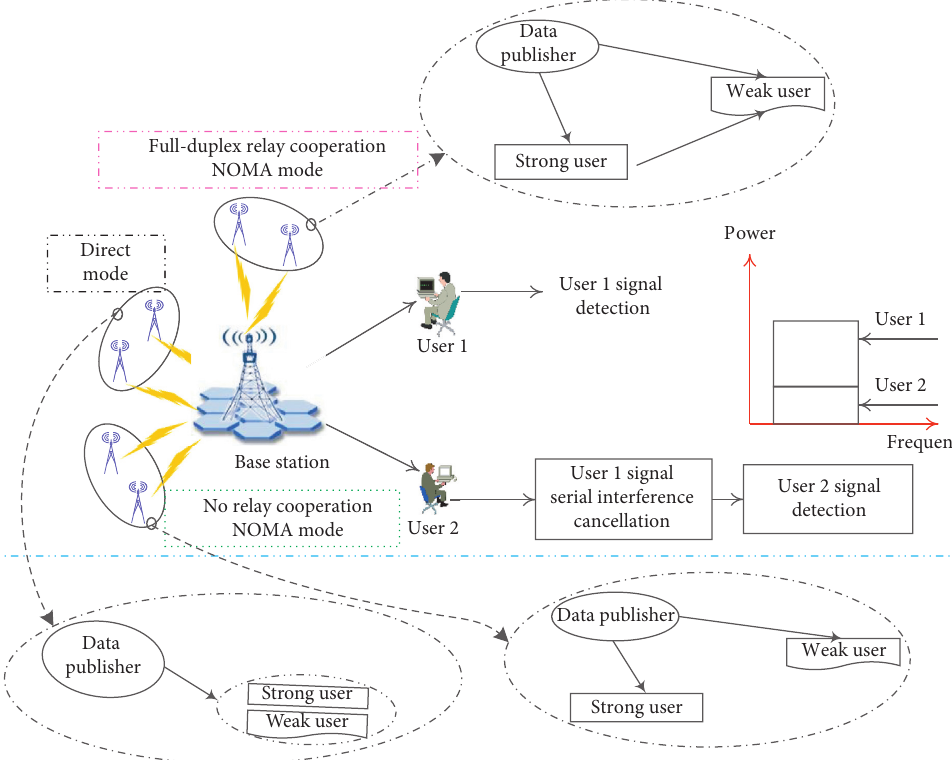
Figure 4: The simulation map used for long-distance communication and construction management.